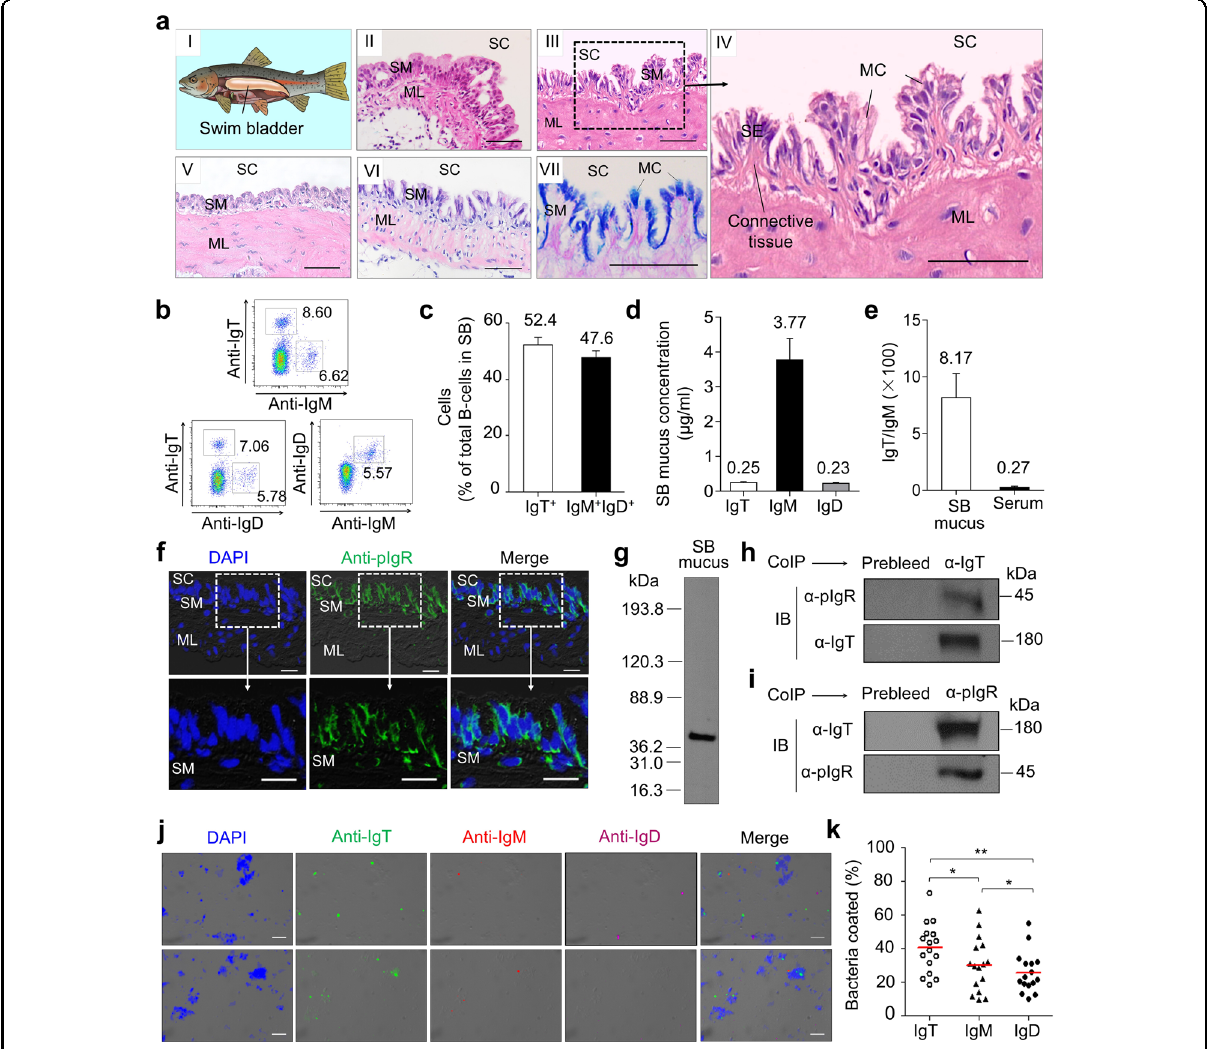
Fig. 1 Morphological structure and presence of MALT in the swim bladder (SB) mucosa of trout. a The anatomy ( a I ) and the structure ( a II – a VII ) of teleost SB. H&E staining of SB mucosa obtained from four different teleost species, including Danio rerio ( a II ), Oncorhynchus mykiss ( a III ; a IV , enlarged section of the area outlined in III ), Osteoglossum bicirrhosum ( a V ) and Salmo salar ( a VI ), and AB-PAS stain of the SB mucosa in naive Oncorhynchus mykiss ( a VII ). SC SB cavity, SE SB epithelium, SM SB mucosa, MC mucus-producing cells, ML muscle layer. Scale bars, 50 μ m. b Representative fl ow cytometry staining of leukocytes from SB with anti-trout Igs mAbs. Numbers adjacent to outlined areas of dot-plots indicate percentage of different B-cell populations (e.g., IgT + B-cells, IgM + B-cells, IgD + B-cells, and IgM + IgD + B-cells) in the lymphocyte gate. c Frequency of IgT + and IgM + IgD + B-cells among the total B-cells ( n = 22). d Concentration of IgT, IgM, and IgD protein levels in SB mucus ( n = 13). e Ratio of IgT to IgM concentration in SB mucus and serum, calculated from the values shown in d and Supplementary Fig. S1d. f Immuno fl uorescence staining for trout pIgR in paraf fi n-sections of trout SB mucosa. Differential interference contrast (DIC) images of SB mucosa paraf fi n-sections were stained with DAPI (blue) for nuclei and anti-trout pIgR pAb (green) ( n = 9) (Isotype-matched control antibody staining is shown in Supplementary Fig. S2a). SC SB cavity, SM SB mucosa, ML muscle layer. Scale bars, 20 μ m. g SDS-PAGE under reducing conditions of trout SB mucus, followed by immunoblot (IB) analysis using anti-trout pIgR pAb. h Co-immunoprecipitation (CoIP) of SB mucus with anti-trout IgT-speci fi c pAb, followed by IB under reducing conditions (pIgR detection, upper panels) or non-reducing conditions (IgT detection, lower panels). i CoIP of SB mucus with anti-trout pIgR pAb, followed by IB under non-reducing conditions (IgT detection, upper panels) or reducing conditions (pIgR detection, lower panels). IgG puri fi ed from rabbit ’ s serum before immunization (Prebleed) served as negative control for rabbit anti-trout IgT and rabbit anti-trout pIgR pAb, respectively (left lane on each panel for h and i ). j DIC images of SB bacteria stained with a DAPI (blue), anti-IgT (green), anti-IgM (red), or anti-IgD (magenta), and merging IgT, IgM, and IgD staining (Merge) (Isotype-matched control antibody staining is shown in Supplementary Fig. S3b). Scale bars, 5 μ m. k Percentages of SB bacteria coated with IgT, IgM, or IgD analyzed by fl ow cytometry ( n = 16). The median percentage is shown by a red line. Statistical differences were evaluated by one-way ANOVA with Bonferroni correction. Data in k are representative of at least three independent experiments (mean± SEM). ANOVA, analysis of variance. * P < 0.05, and ** P <